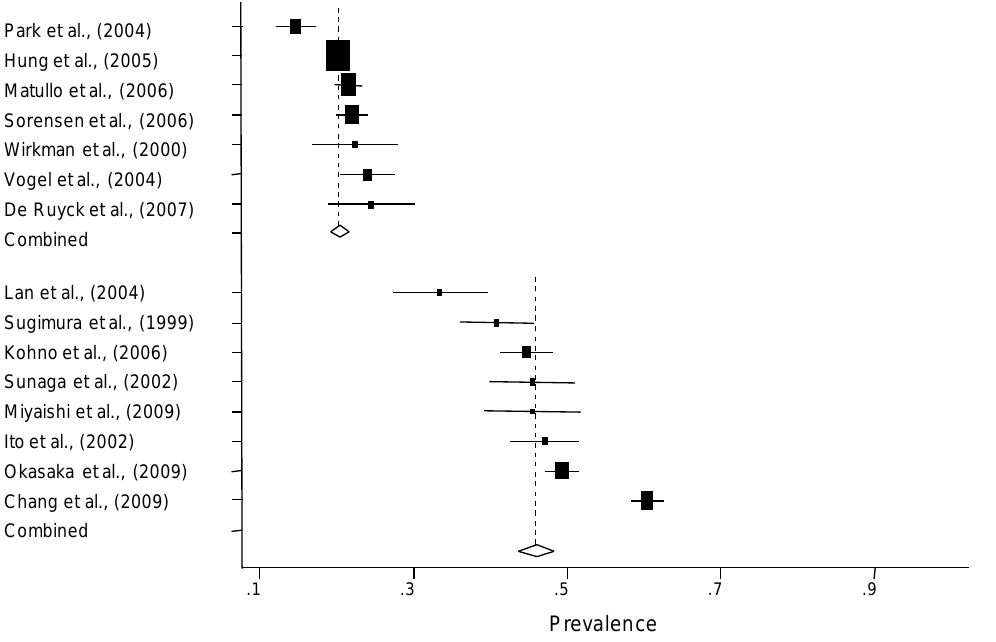
Figure 1. The Cys allele frequency of seven Caucasian populations and eight Asian populations among controls. The center of a box and the horizontal line indicate the prevalence and the 95% CI in each study, with the areas of the box representing the weight of each study. The summary prevalence based on the random effects model is represented by the middle of a diamond whose width indicates the 95% CI. The summary prevalence is also shown by the dotted vertical line. The summary prevalence of Caucasians and Asians based on the random effects model are 20.9% (95% CI = 18.9–22.9; Cochran Q test: Q statistic = 28.23, P < 0.0001) and 46.1% (95% CI = 40.2–52.0; Cochran Q test: Q statistic = 144.7, P < 0.0001), respectively. The distribution of the Cys allele was significantly different between Asians and Caucasians (P <